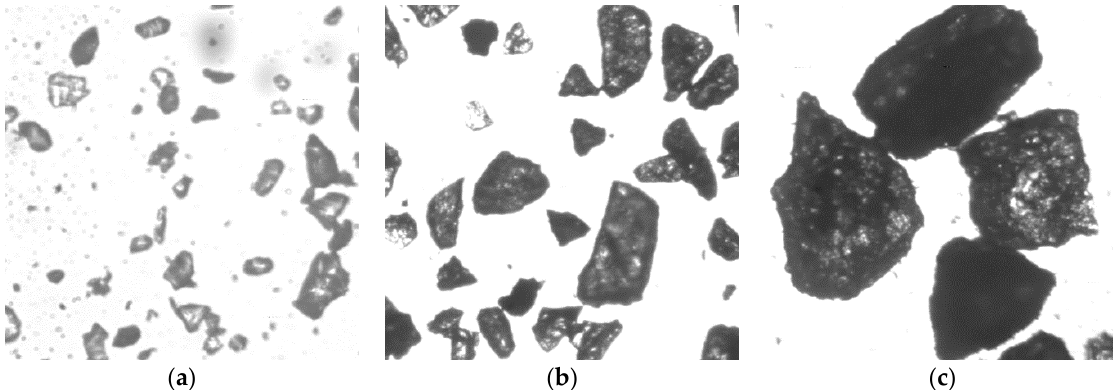
Figure 7. Microscopic morphology of the sand particles used in the test: ( a ) D 32 = 65 μ m; ( b ) D 32 = 226 μ m; ( c ) D 32 = 336 μ m.